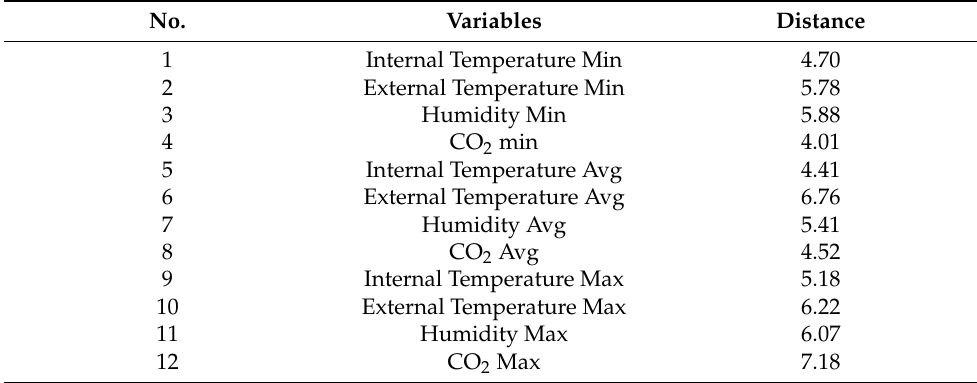
Table 2. DTW distance between environment variables and tomato